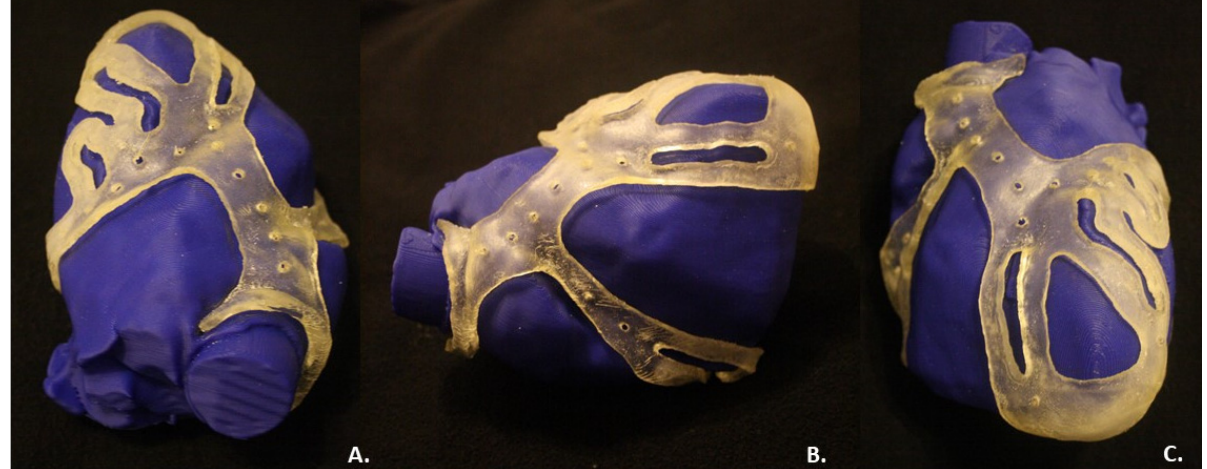
Figure 7. Fitting test of the surgical guide on the phantom heart: ( A ) Above view; ( B ) Right lateral view; ( C ) Frontal view.